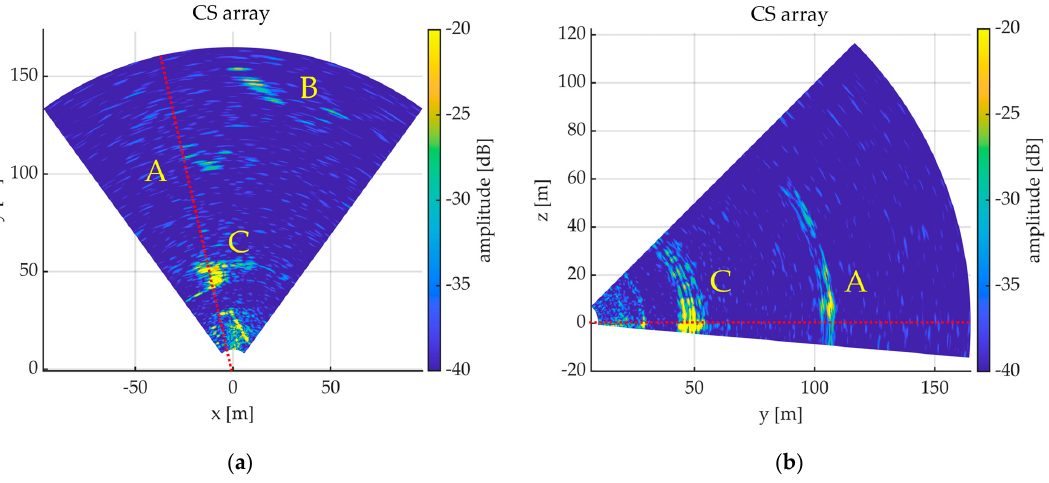
Figure 12. Radar images acquired with the CS array focused on the x-y plane ( a ) and on the y-z plane ( b ). Dotted line is the intersection between the two orthogonal image planes.